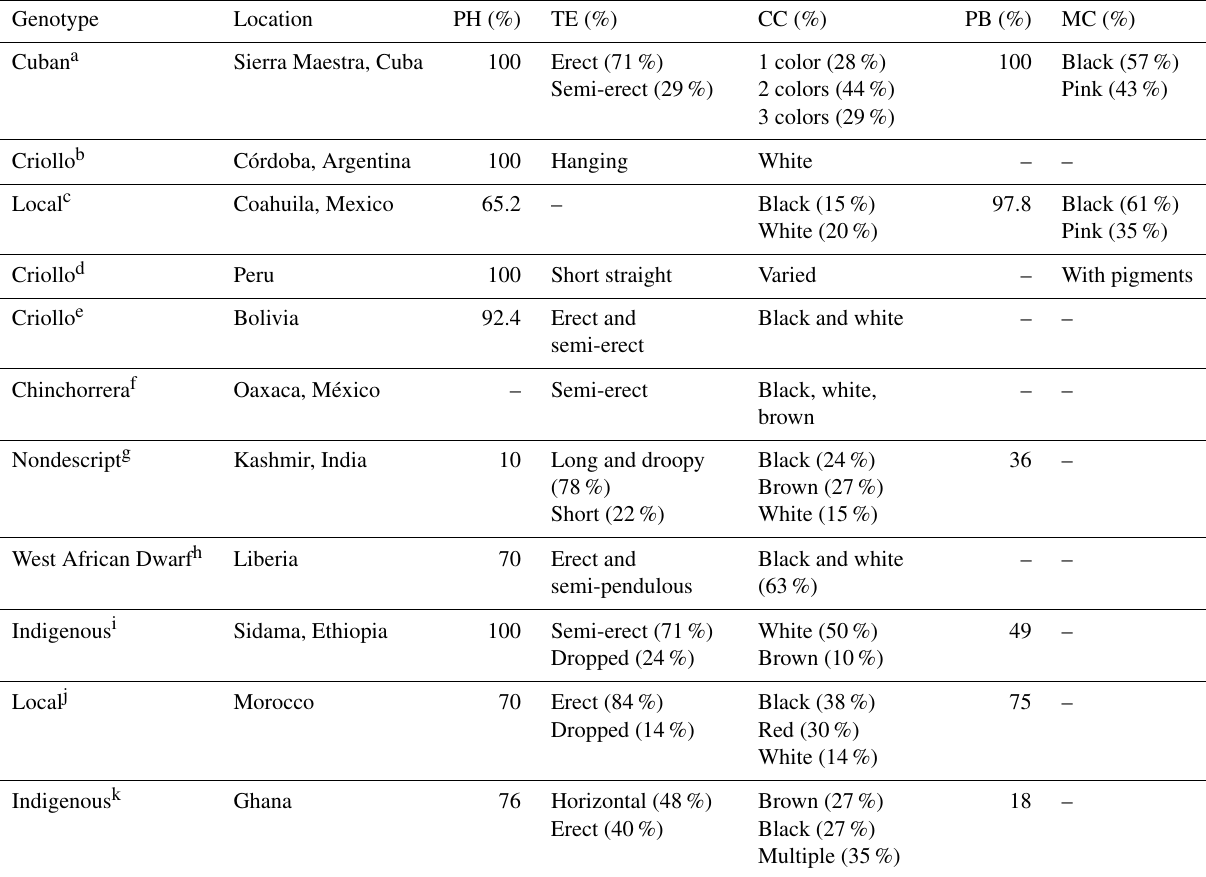
Table 1. Phaneroptic characteristics in local goats from various countries of the world. Genotype